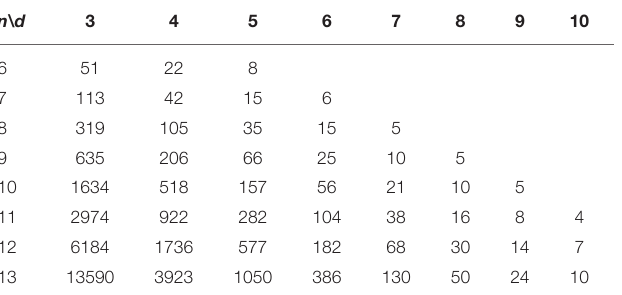
TABLE 10 | Lower bounds for A GC , NL , NS ( n , d , and w ).